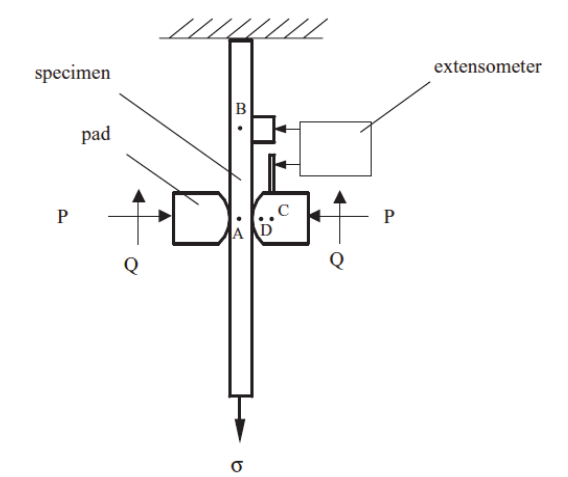
Figure 1: Schematic of cylinder on flat fretting fatigue test configuration